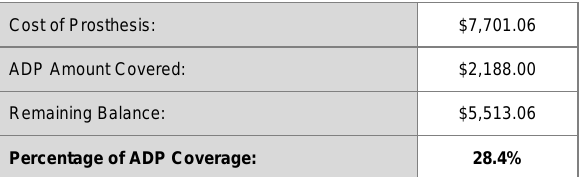
Table 3: ADP Coverage for the replacement of a left below elbow myoelectric socket due to